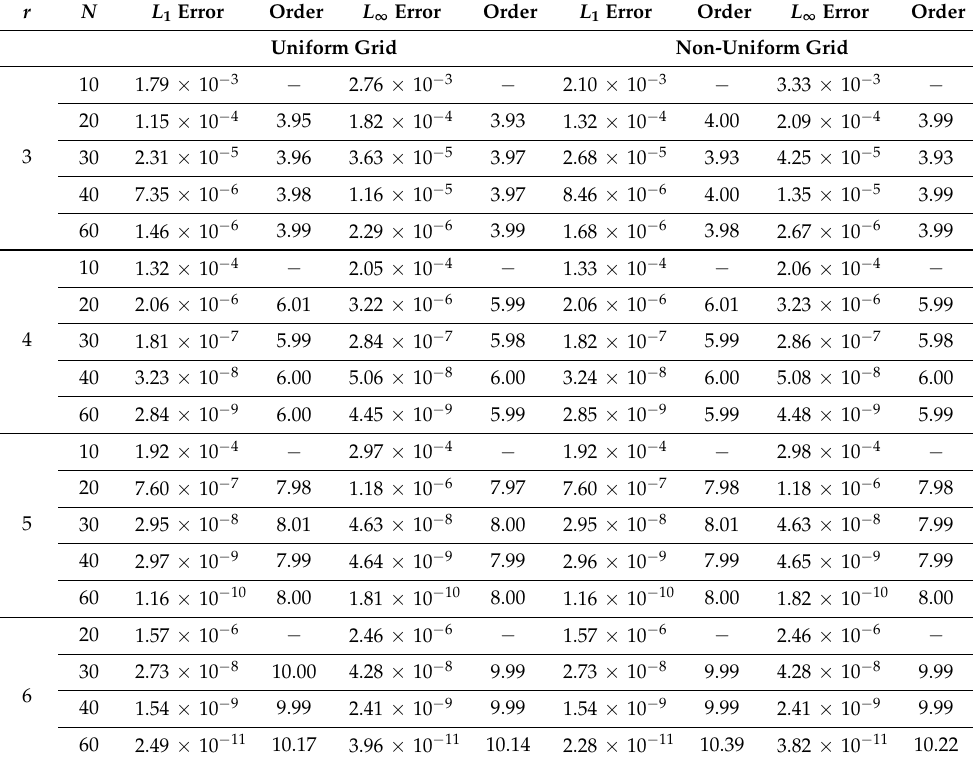
Table 1. Accuracy test for linear hyperbolic law with initial condition u ( x ,0 ) = sin ( x ) at t = 2 π